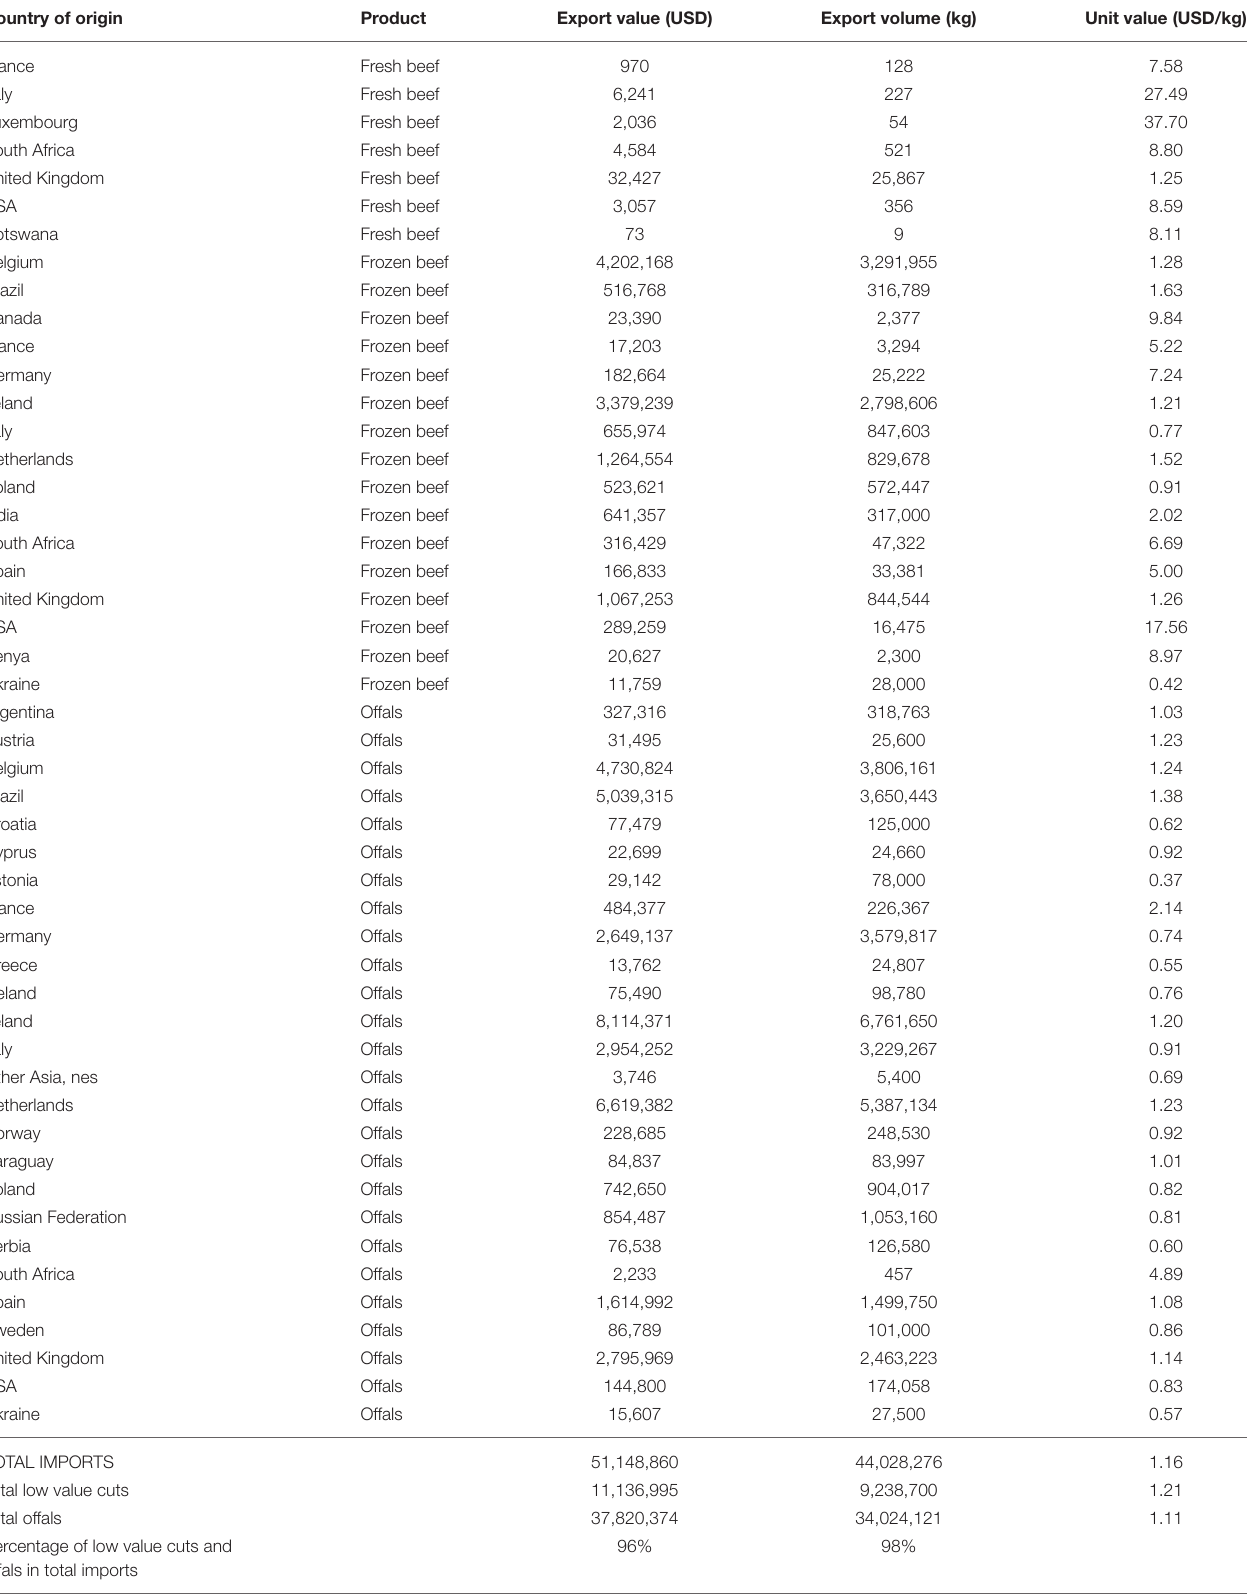
TABLE 3 | Disaggregation of beef exports to Ghana by country of origin, 2018. Country of